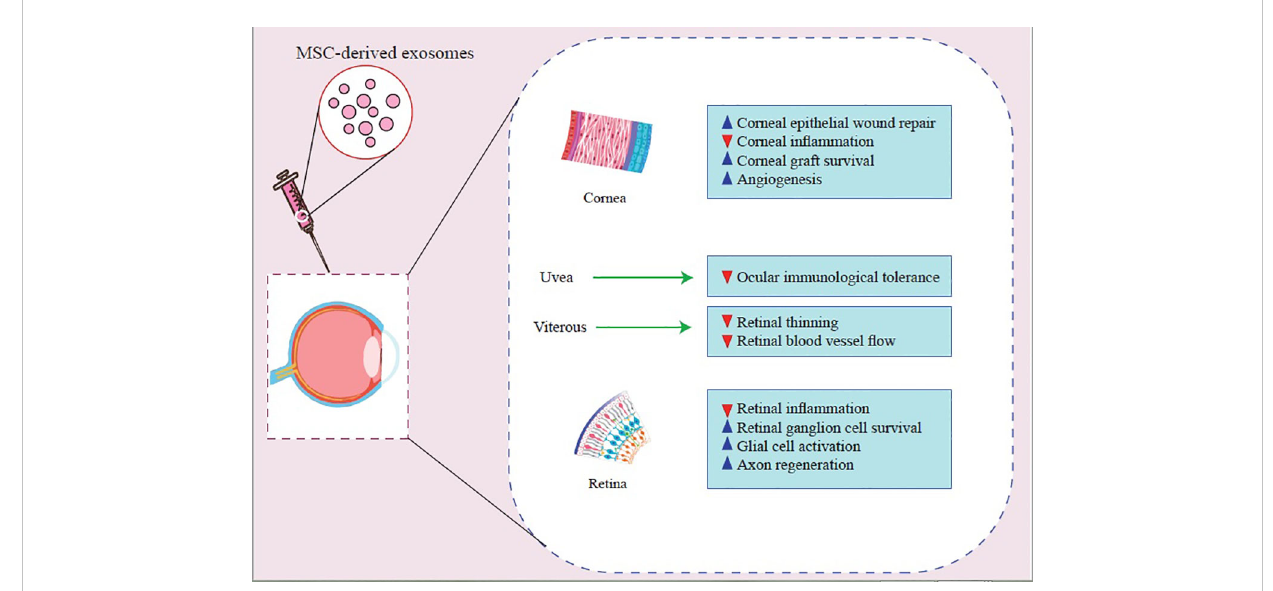
FIGURE 2 Molecular mechanisms that contribute to MSC-Exos ’ bene fi cial effects on treating in fl ammatory ocular